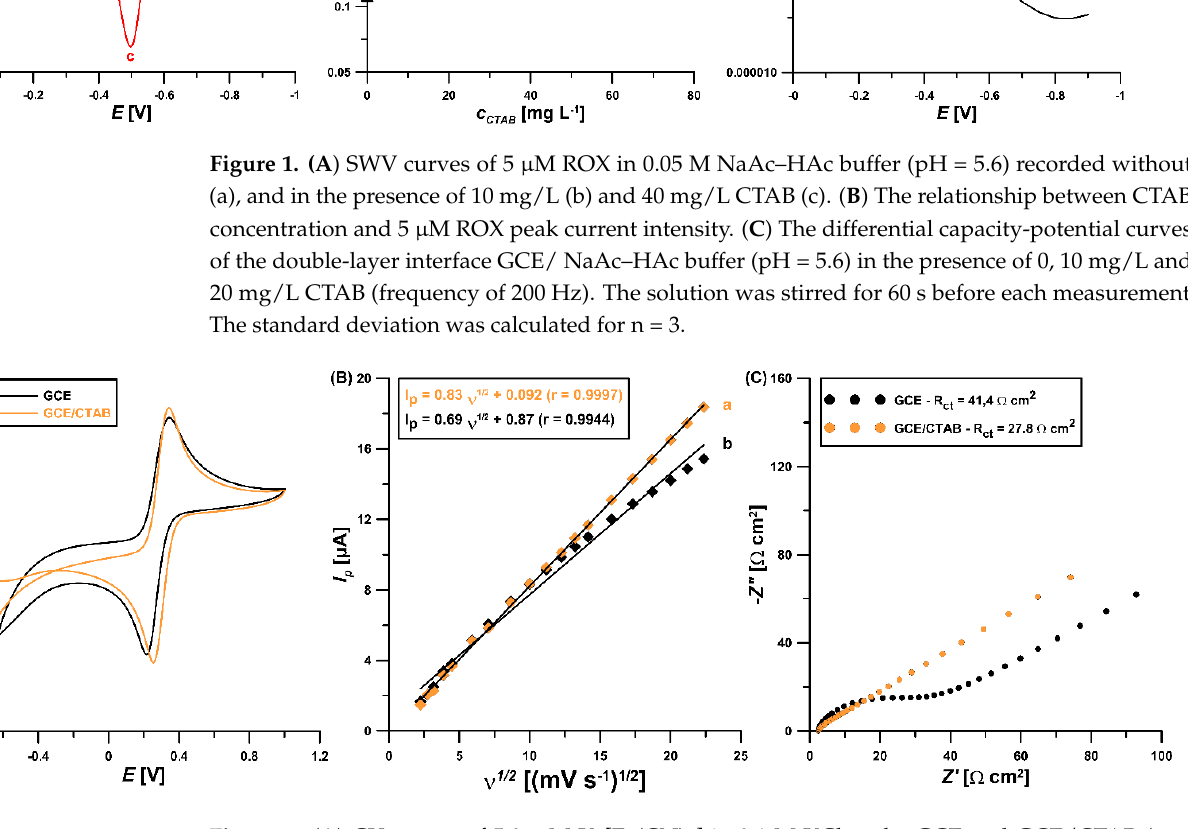
Figure 2. ( A ) CV curves of 5.0 mM K 3 [Fe(CN) 6 ] in 0.1 M KCl at the GCE and GCE/CTAB ( υ of 500 mV/s). ( B ) The relationship between I p and υ 1/2 at the GCE/CTAB (a) and GCE (b). ( C ) Nyquist diagrams of the GCE and